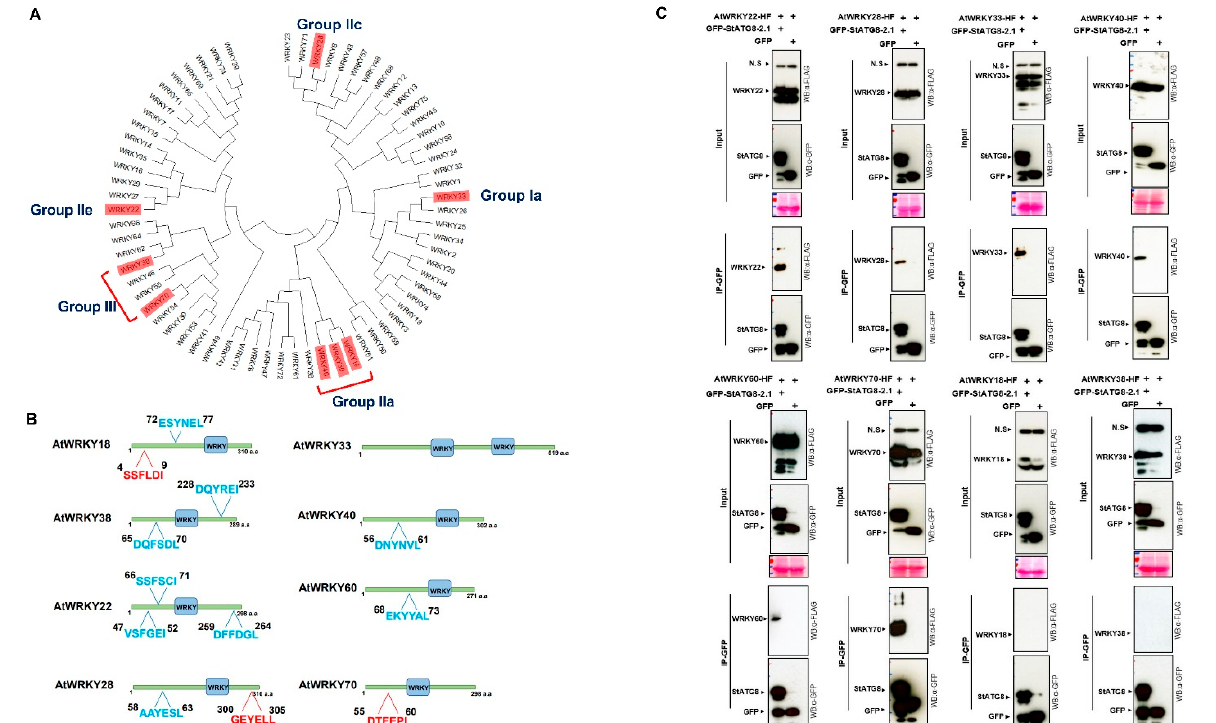
Figure 6. StATG8 associated with WRKY transcription factors in planta . ( A ) Phylogenetic relationships of protein sequences within the AtWRKY family. The tree was constructed from an analysis conducted with MEGA-X software using a maximum likelihood method [51]. AtWRKYs used for CoIP are shown in red boxes. ( B ) Analysis of putative ATG8 binding motifs present in AtWRKY utilizing the iLIR database on 1 to 25 June 2022 [52]. ATG8 interacting proteins have a LC3-interacting region (LIR) and Atg8-interacting motif (AIM) responsible for interaction with ATG8 family proteins. In AtWRKYs, LIR motifs are shown in red text and AIM motifs are shown in blue text. AtWRKY18, AtWRKY40, and AtWRKY60 protein sequence analysis corresponds to group II-a. Only AtWRKY18 contains a putative LIR motif at the N-terminal end. AtWRKY33 do not contain any ATG8-binding related motifs. ( C ) Co-immunoprecipitation (coIP) assays reveal that StATG8 is associated with multiple AtWRKY transcription factors. Agrobacterium -mediated transient co-expression of GFP-StATG8-2.1 or GFP control with AtWRKY-22-HF , AtWRKY-28-HF , AtWRKY-33-HF , AtWRKY-40-HF , AtWRKY-60-HF , AtWRKY-18-HF , AtWRKY-20-HF , and AtWRKY-38-HF , and AtWRKY-70-HF was performed in N. benthamiana leaves. Anti-GFP co-IPs were performed with total protein extracts and probed with anti-GFP and -FLAG antibodies. All experiments were performed for at least three